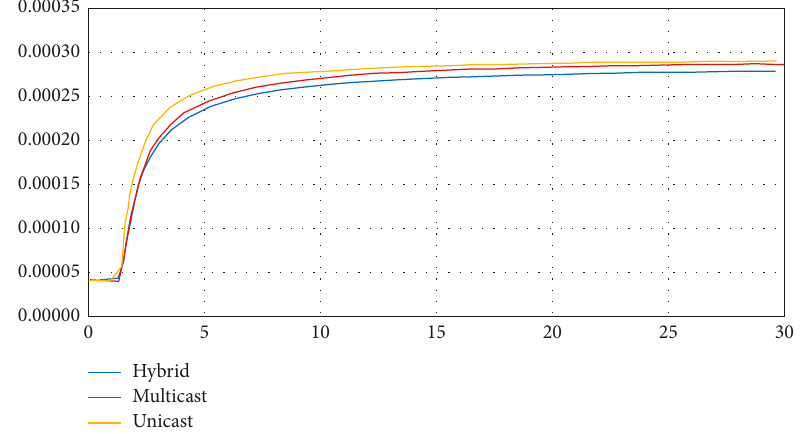
Figure 8: End-to-end